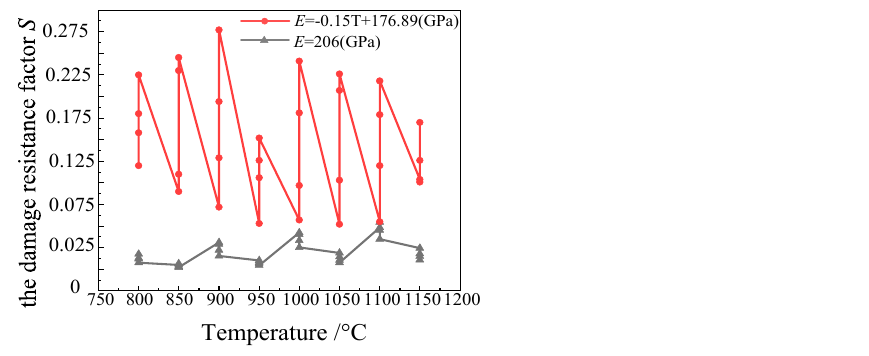
Figure 6. Comparison of the damage parameter S values of Cr5 alloy steel with different elastic moduli.